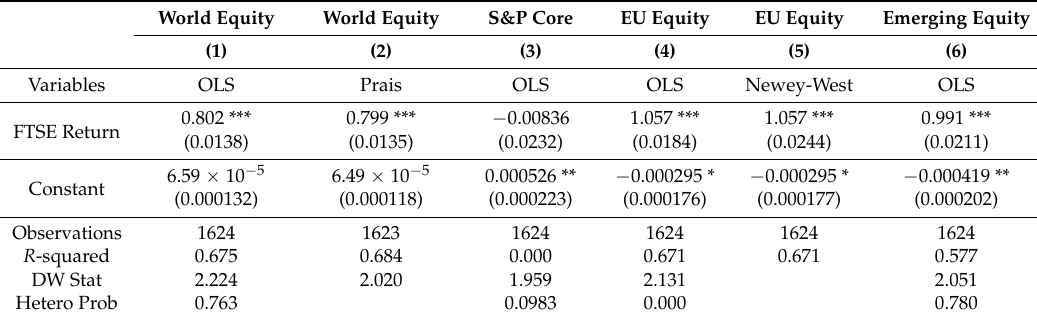
Table 4. Regression Models-Equity